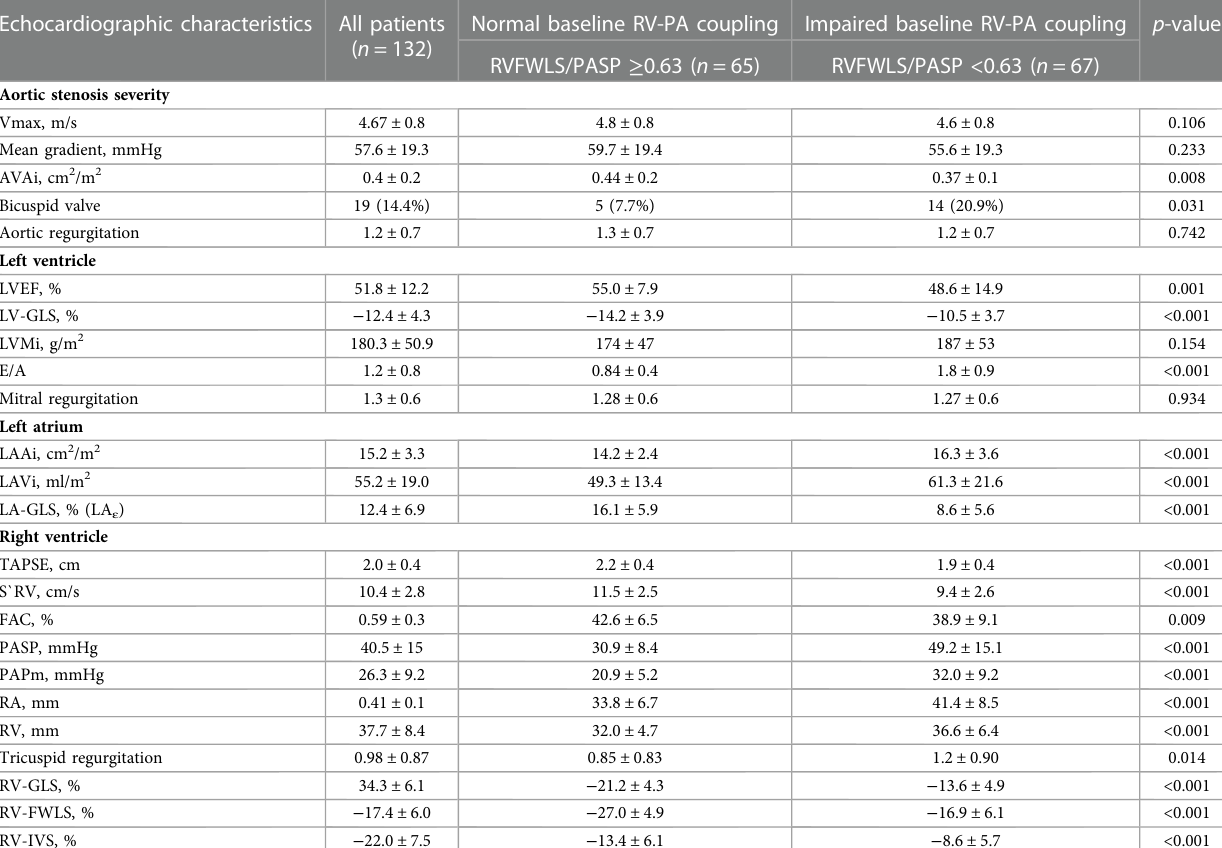
TABLE 2 Echocardiographic characteristics. Echocardiographic